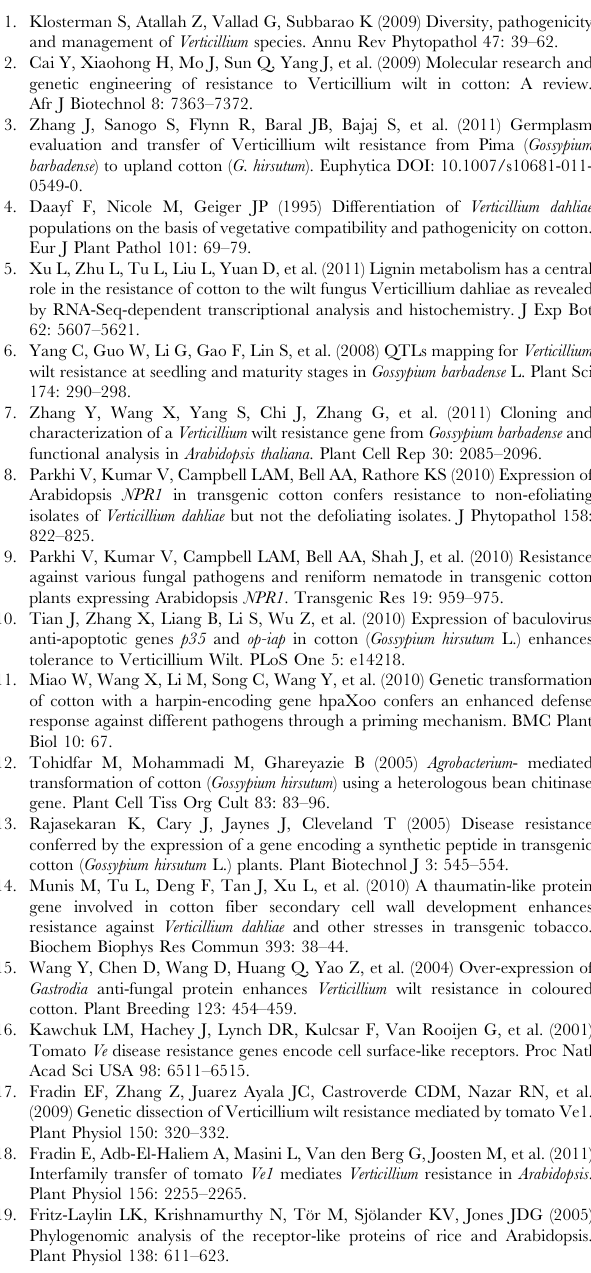
Table S1 The characterized domains in the promoter of